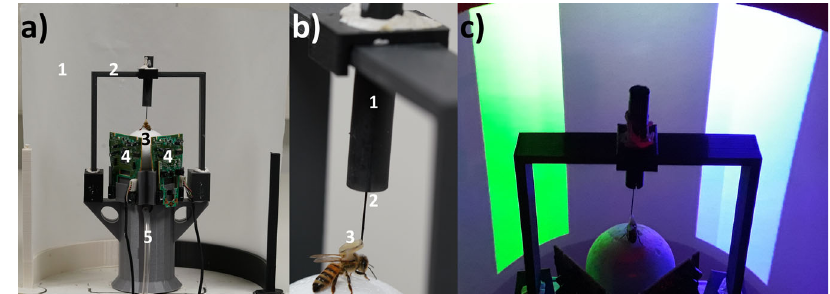
Fig. 1 Experimental setup and 3D environment. a Global view of the VR system. (1) Semicircular projection screen made of tracing paper. (2) Holding frame to place the tethered bee on the treadmill. (3) The treadmill was a Styrofoam ball positioned within a cylindrical support (not visible) fl oating on an air cushion. (4) Infrared mouse optic sensors allowing to record the displacement of the ball and to reconstruct the bee ’ s trajectory. (5) Air arrival. The video projector displaying images (not visible) was behind the screen. b The tethering system. (1) Plastic cylinder held by the holding frame; the cylinder contained a glass cannula into which a steel needle was inserted. (2) The needle was attached to the thorax of the bee. (3) Its curved end was fi xed to the thorax by means of melted bee wax. c Color discrimination learning in the VR setup. The bee had to learn to discriminate two vertical stimuli based on their different color and their association with reward and punishment. Stimuli were green and blue on a dark background. Color intensities were adjusted to avoid phototactic biases independent of learning. question, we analyzed for each conditioning trial the total distance walked, the walking speed, and the tortuosity of the trajectories. Tortuosity was calculated as the ratio between the total distance walked and the distance between the fi rst and the last point of the trajectory connected by an imaginary straight line. When the ratio was 1, or close to 1, trajectories were straightforward while higher values corresponded to sinuous trajectories. The distance travelled (Fig. 4a) did neither vary along trials (Trial: χ 2 = 0.24, df:1, p = 0.62) nor between learners and non-learners (Condition: χ 2 = 1.10, df:1, p = 0.30; Condition * Trial: χ 2 = 0.71, df:1, p = 0.40). Tortuosity (Fig. 4b) varied along trials (Trial: χ 2 = 14.53, df:1, p < 0.001) but not between learners and non-learners (Condition: χ 2 = 0.08, df:1, p = 0.80; Condition * Trial: χ 2 = 0.42, df:1, p = 0.52). Finally, the walking speed (Fig. 4c) increased signi fi cantly along trials (Trial: χ 2 = 30.49, df:1, p < 0.0001) but did not vary between learners and non-learners (Condition: χ 2 = 1.43, df:1, p = 0.23); in this case, however, the interaction between Trial and Condition was signi fi cant ( χ 2 = 4.68, df:1, p < 0.05). This suggests that learners